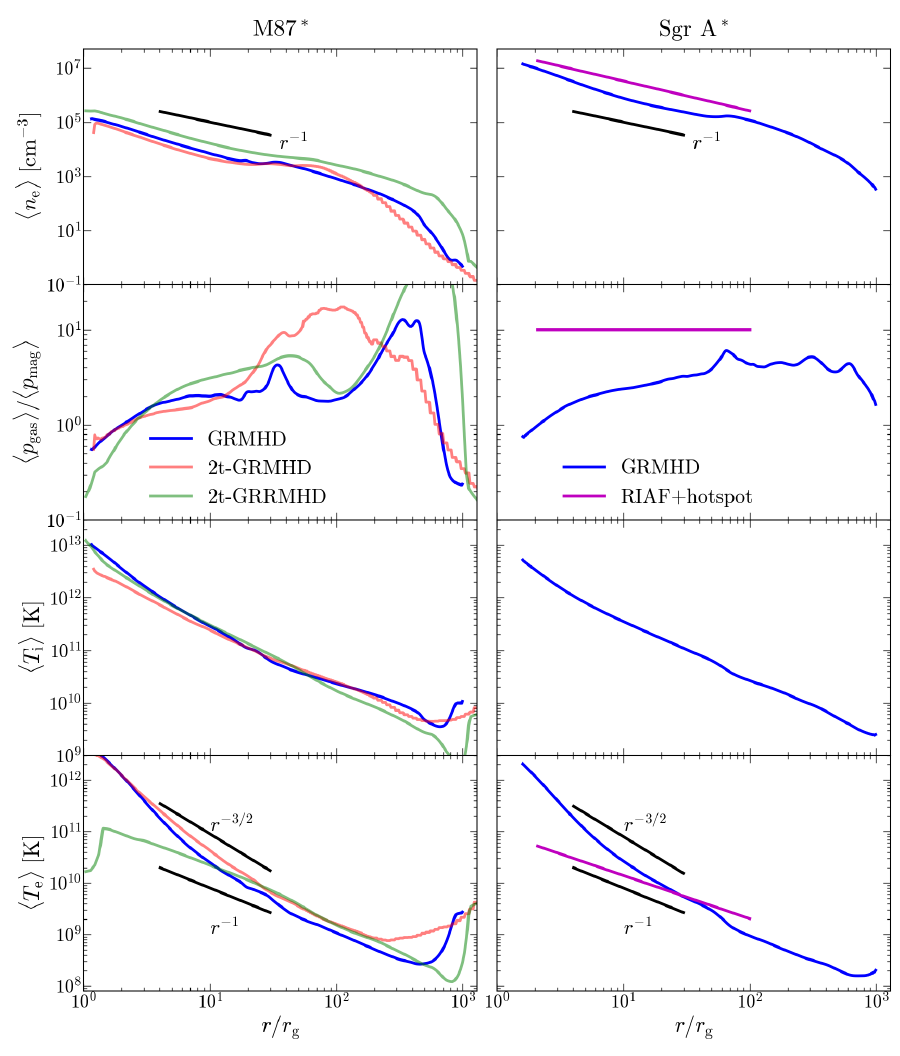
Figure 3. We show the radial profiles of gas density ρ , plasma − β , proton temperature T p , and electron temperature T e . Quantities are disk-averaged and time-averaged over the raytracing